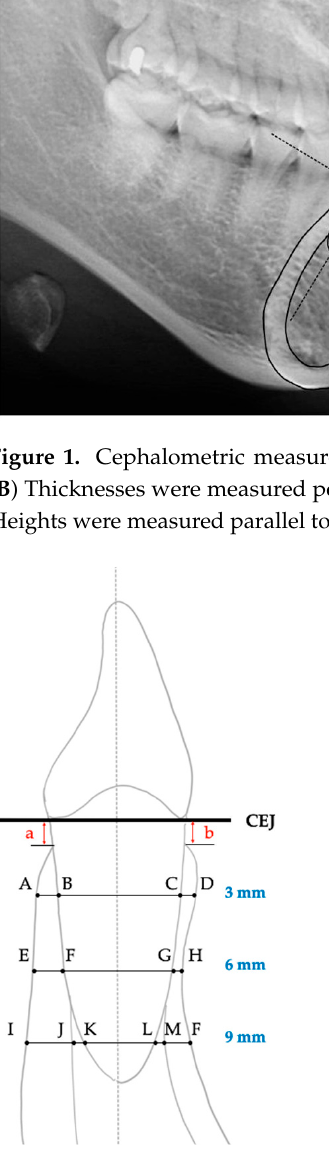
Figure 2. Measurements. On the labial side, labial alveolar bone thicknesses C-D, G-H, and L-F; labial cortical bone thicknesses C-D, G-H, and M-F; labial cancellous bone thickness L-M; labial alveolar bone height distance b. On the lingual side, lingual alveolar bone thicknesses A-B, E-F, and I-K; lingual cortical bone thicknesses A-B, E-F, and I-J; lingual cancellous bone thickness J-K; lingual alveolar bone height distance b; and root diameters B-C, F-G, and K-L and total root-bone thicknesses A-D, E-H, and